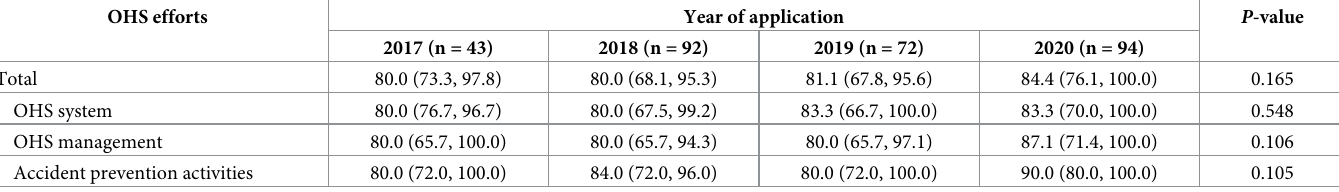
Data were presented as median (interquartile